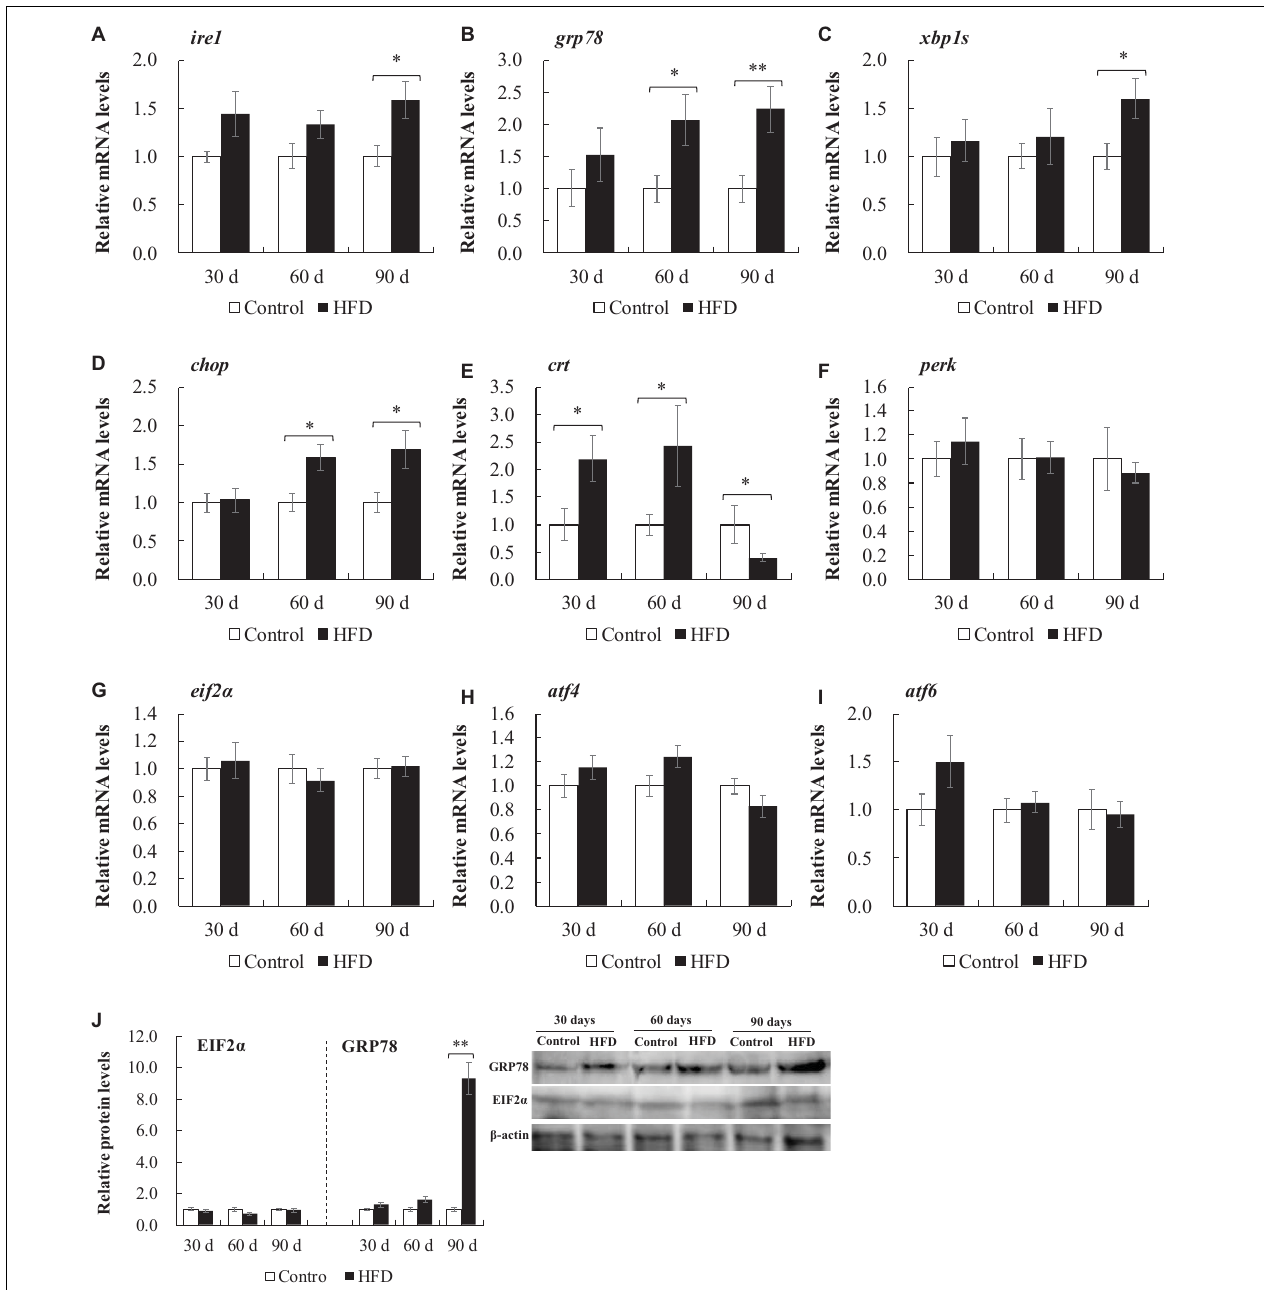
FIGURE 6 | Expression of endoplasmic reticulum stress-related genes or proteins in liver of tilapia fed on control diet and HFD for 90 days. (A–I) Expression of endoplasmic reticulum stress-related genes ( n = 10). (J) Representative immunoblotting and relative protein expression of GRP78 and EIF2 α ( n = 3). The values are normalized to control values and expressed as means ± SEM; ∗ P < 0.05 and ∗∗ P < 0.01 versus control at same time.